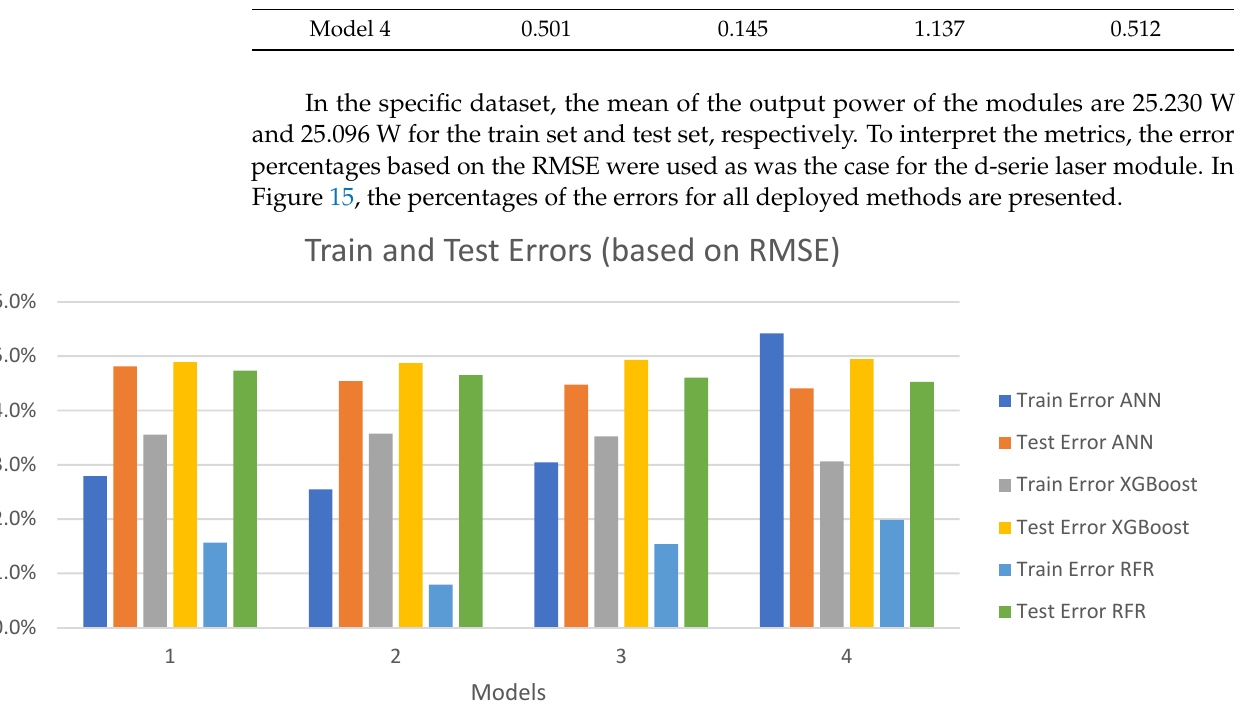
Table 12. Train and test RMSE and MAE for all XGBoost models. XGBoost